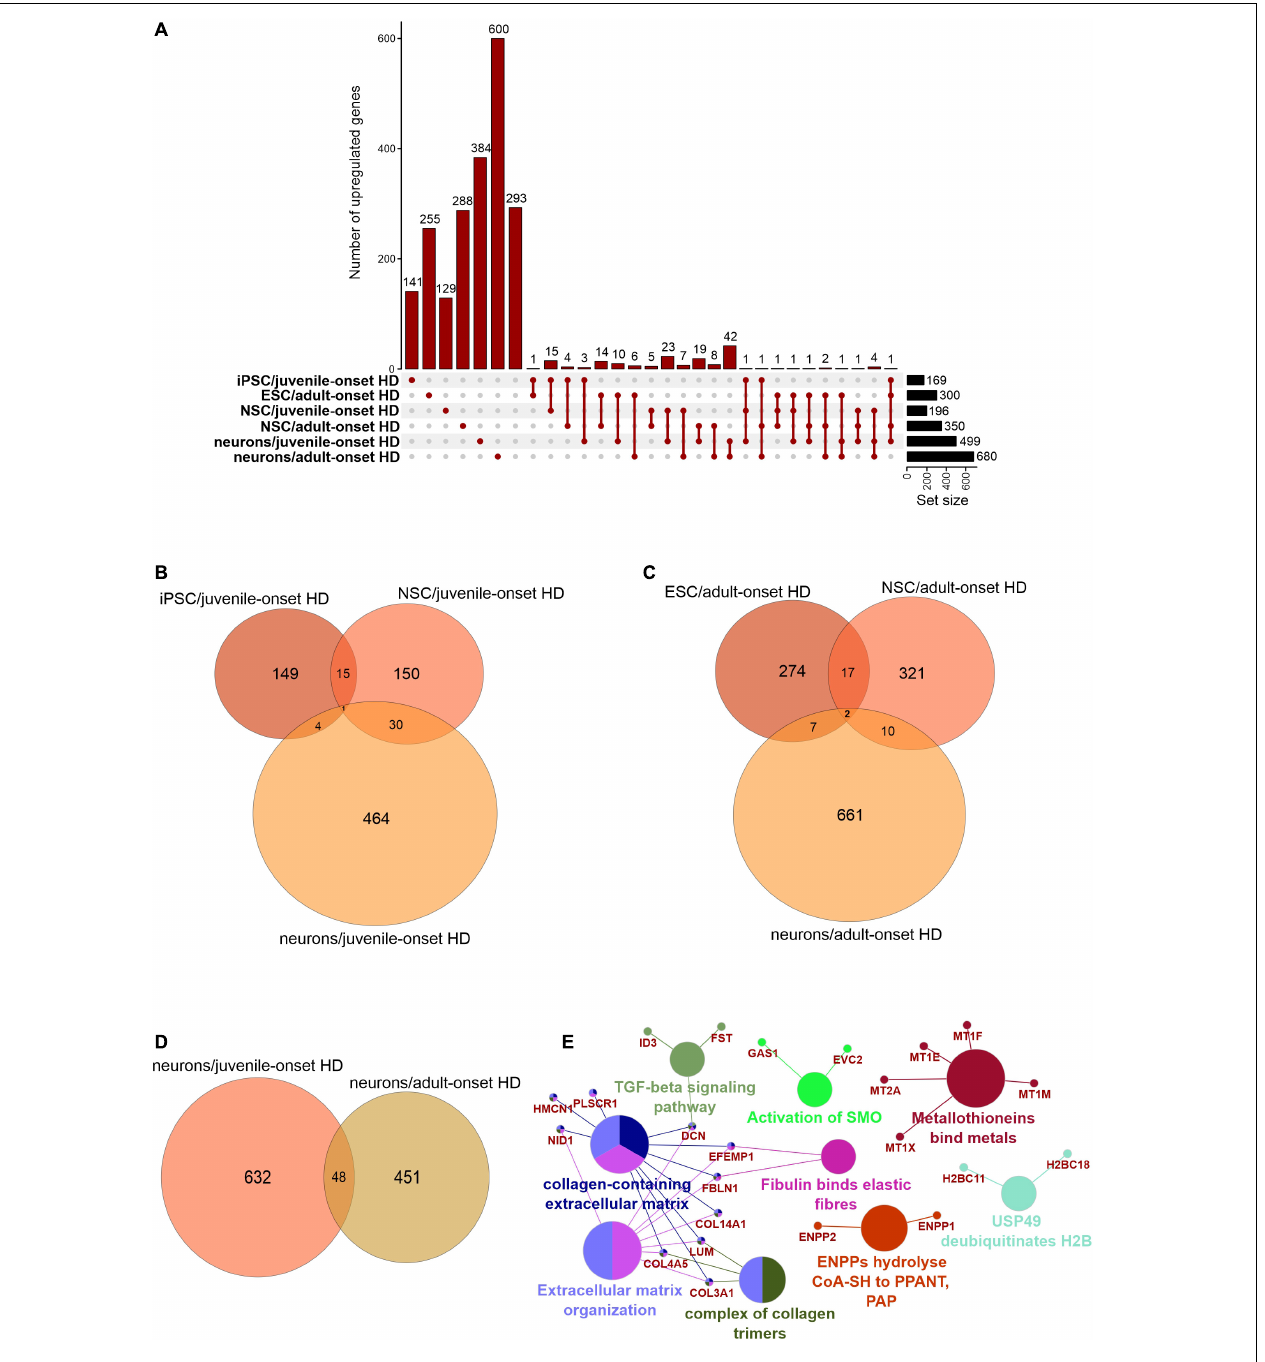
FIGURE 2 | Analysis of Juvenile- and adult Huntington disease transcriptomic data demonstrates mostly specific sets of upregulated genes for each type of onset. (A) UpsetR graph showing the overlap between genes identified in the different HD cell types. Venn diagrams were used to visualize the overlap between genes from juvenile HD iPSC, NSC, and neurons (B) , for genes from adult HD iPSC, NSC, and neurons (C) , and for genes from juvenile and adult neurons (D) . Similar to Supplementary Figure 1D , the juvenile HD and adult HD neurons vastly differ in dysregulated genes, showing only 48 genes in common. These commonly downregulated genes are visualized with a CluGO plot (E)